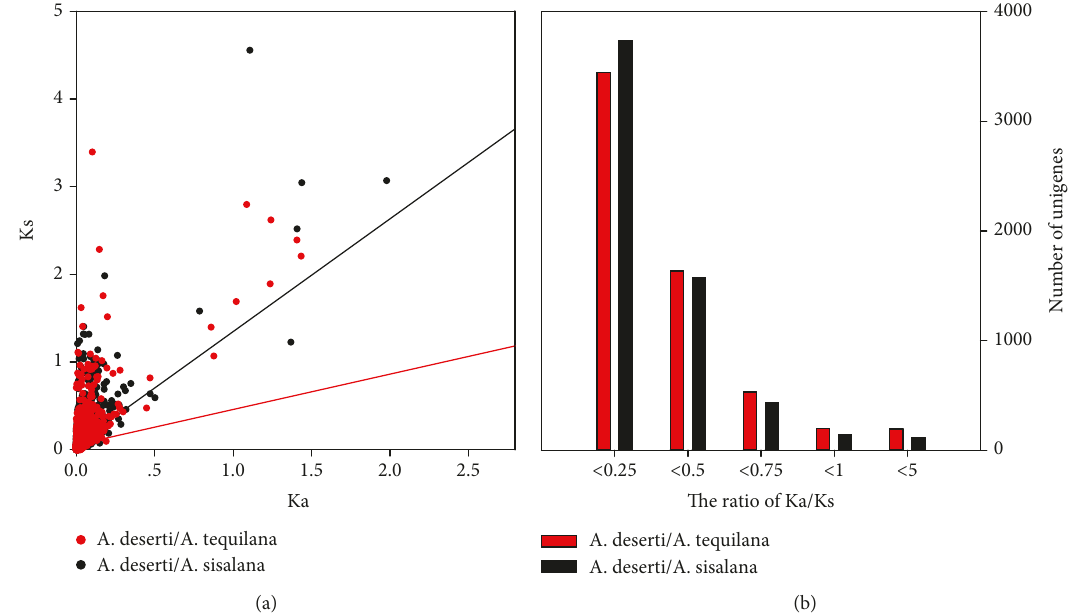
Figure 4: The nonsynonymous (Ka) and synonymous (Ks) nucleotide substitutions, as well as their Ka/Ks ratio. (a) The scatter diagram of Ka and Ks values of A. tequilana (red) and A. sisalana (black) compared with A. deserti , respectively. (b) The Ka/Ks distribution of A. tequilana (red) and A. sisalana (black) compared with A. deserti , respectively. The x -axis indicates the ratio of Ka/Ks. Table 2: Characterization of signi fi cant selection unigenes. Signi fi cant selection unigenes Classi fi cation In Total